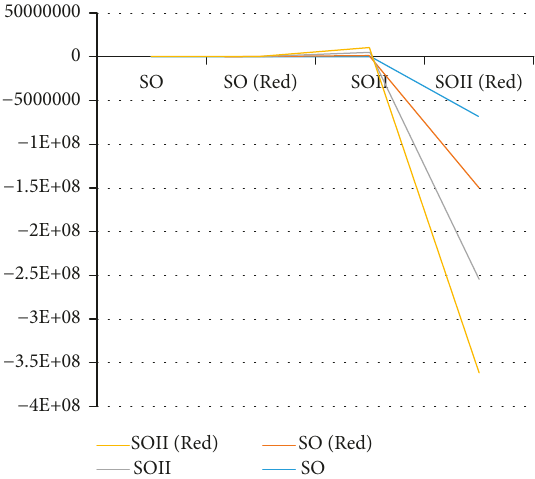
Figure 11: Graphical comparison of SO , SO